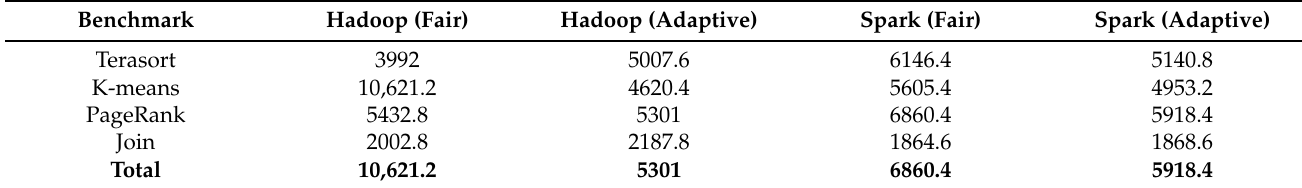
Table 5. Summary of concurrent container executions (sec).